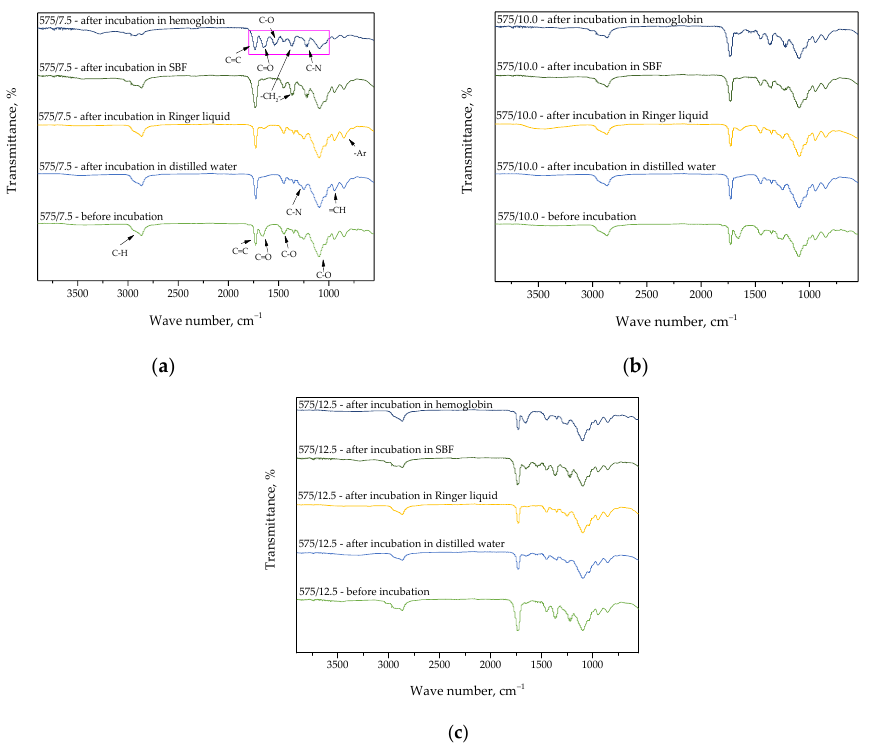
Figure 16. FT-IR spectra showing the impact of the incubation on the structure of sample 575/7.5 ( a ), 575/10.0 ( b ), and 575/12.5 ( c ).